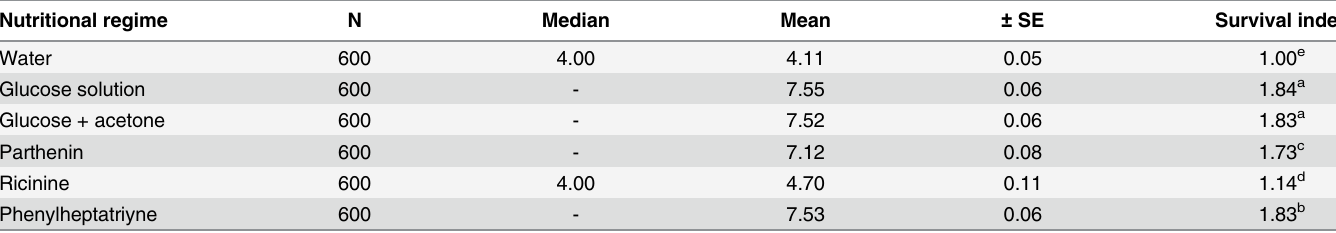
N = total number of mosquitoes assayed, SE = standard error, - = median not estimated, number followed by different letter superscript in the survival index column differ signi fi cantly ( P < 0.05). The secondary metabolites were presented in 6% glucose solution. The surviving mosquitoes from each treatment were censored on day